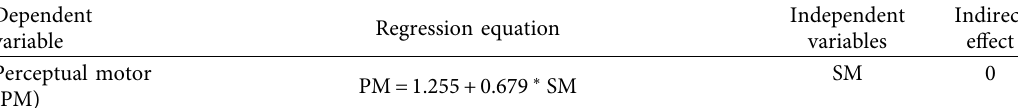
Table 11: Path analysis